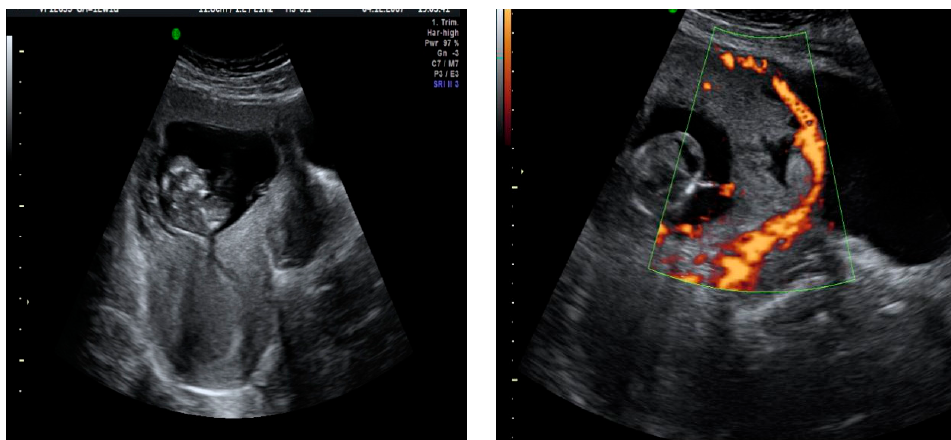
Figure 5. Ultrasound displaying (at left and right ) a thinned myometrium area with a solution of continuity between the gestational sac and the bladder.